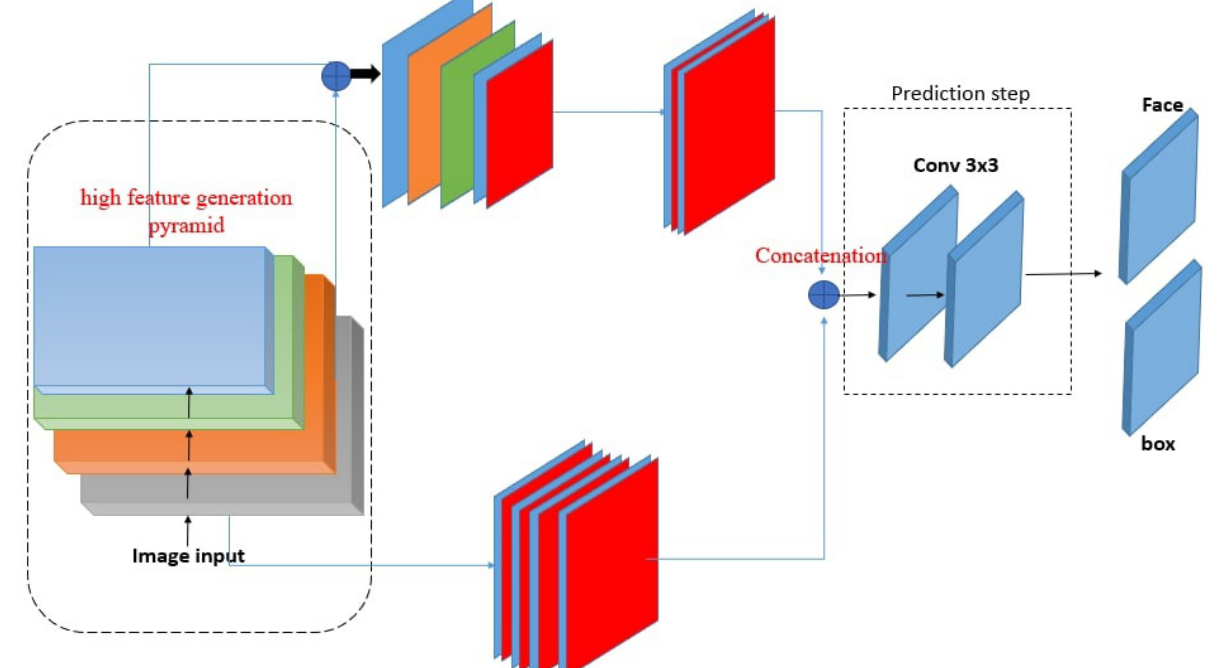
Figure 1. Architecture of proposed method for face detection.